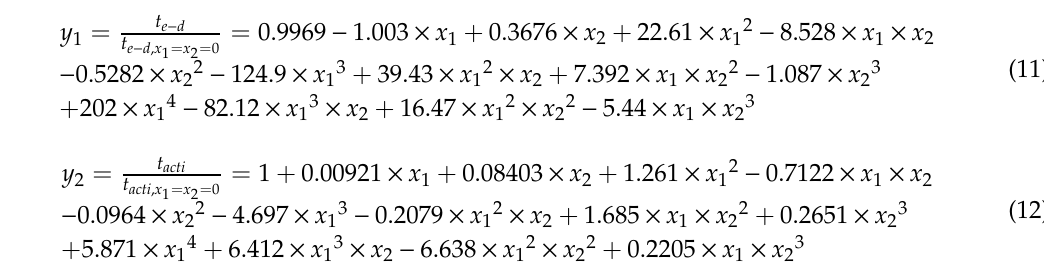
1 ; ( b ) fitting surface of y 2